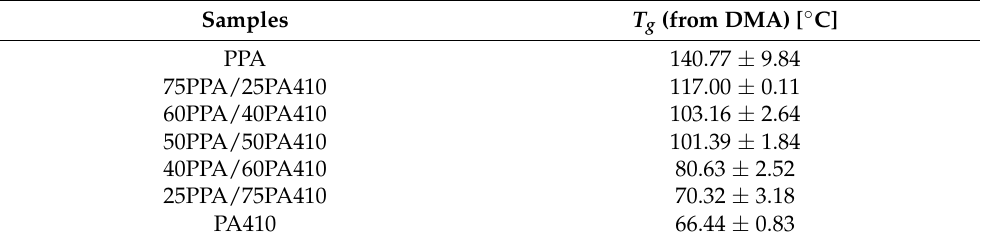
Figure 6. DMA curves of the PPA, PA410 and their blends; ( A ) dependence of tan ( δ ) on the temperature; ( B ) dependence of storage modulus on temperature. Table 4. The glass transition temperature ( T g ) obtained from the tan ( δ ) curves from DMA testing.